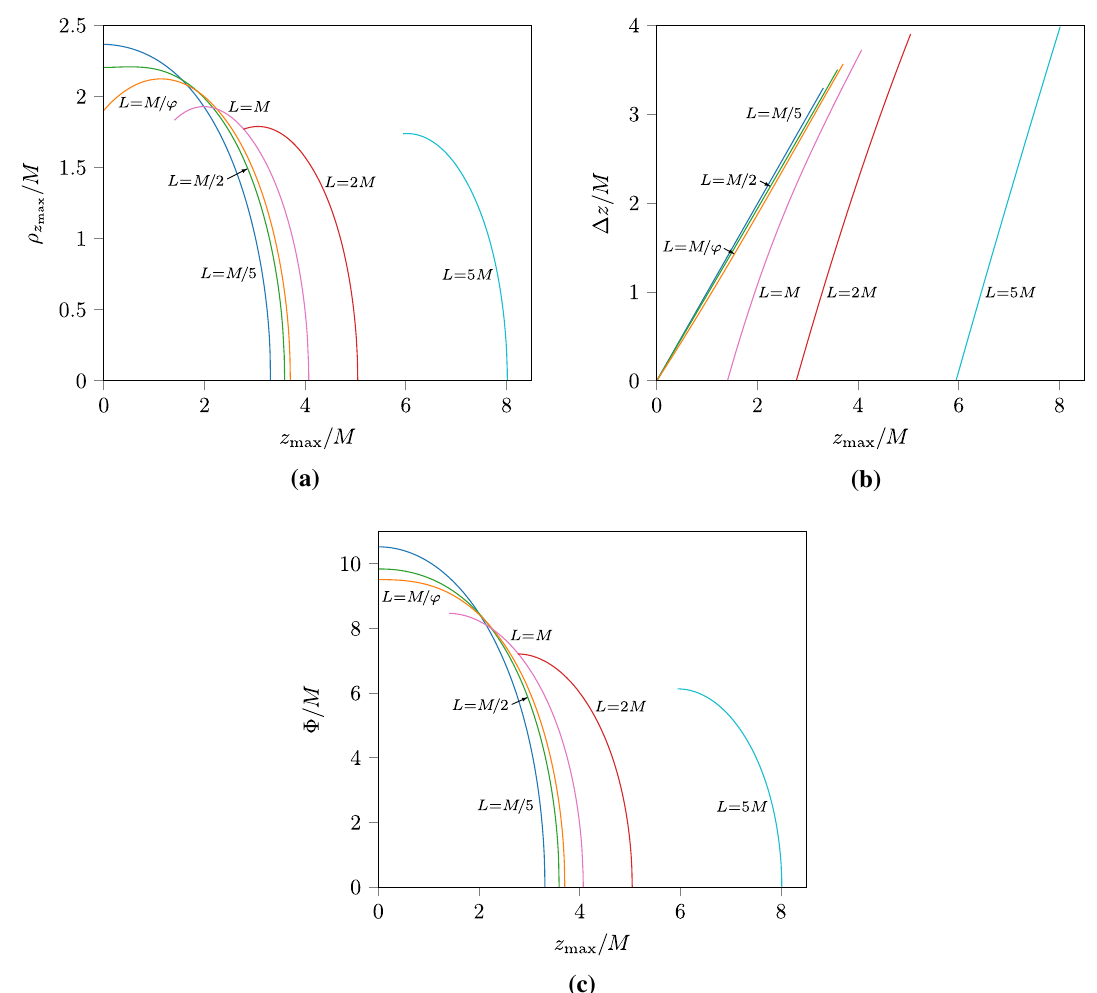
Fig. 10 Plots of a ρ z against z max , b (cid:10) z against z max , and c (cid:9) against z max , for the Class B FPOs, for various values of L as indicated max Table 2 The lower and upper bounds of z max , for the various values of L plotted in Fig. 10. Non-zero values are listed to an accuracy of six significant figures. The orbit types corresponding to the lower/upper bounds are also